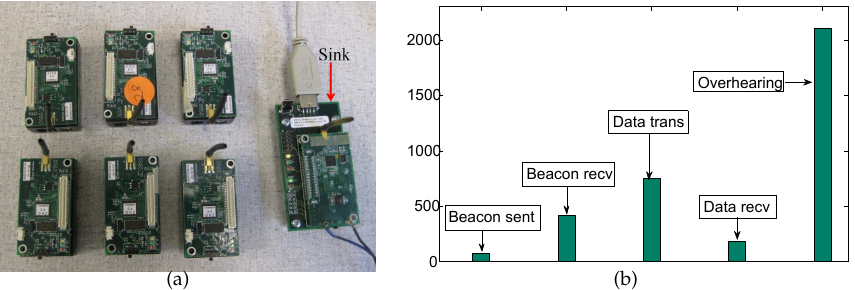
Figure 1. ( a ) Experimental setup to assess the activities of the radio; and ( b ) comparison of radio activities in a wireless sensor node performing data collection.